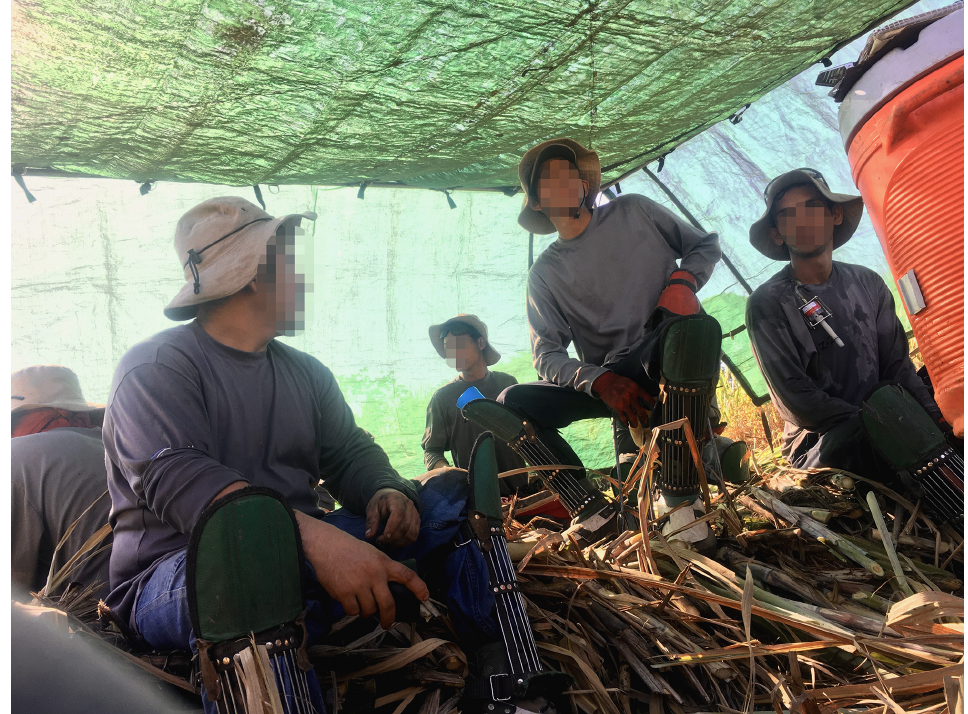
Figure 5. Lightweight shade tents provided sufficient space for 15 workers but were easily portable to permit moving along the